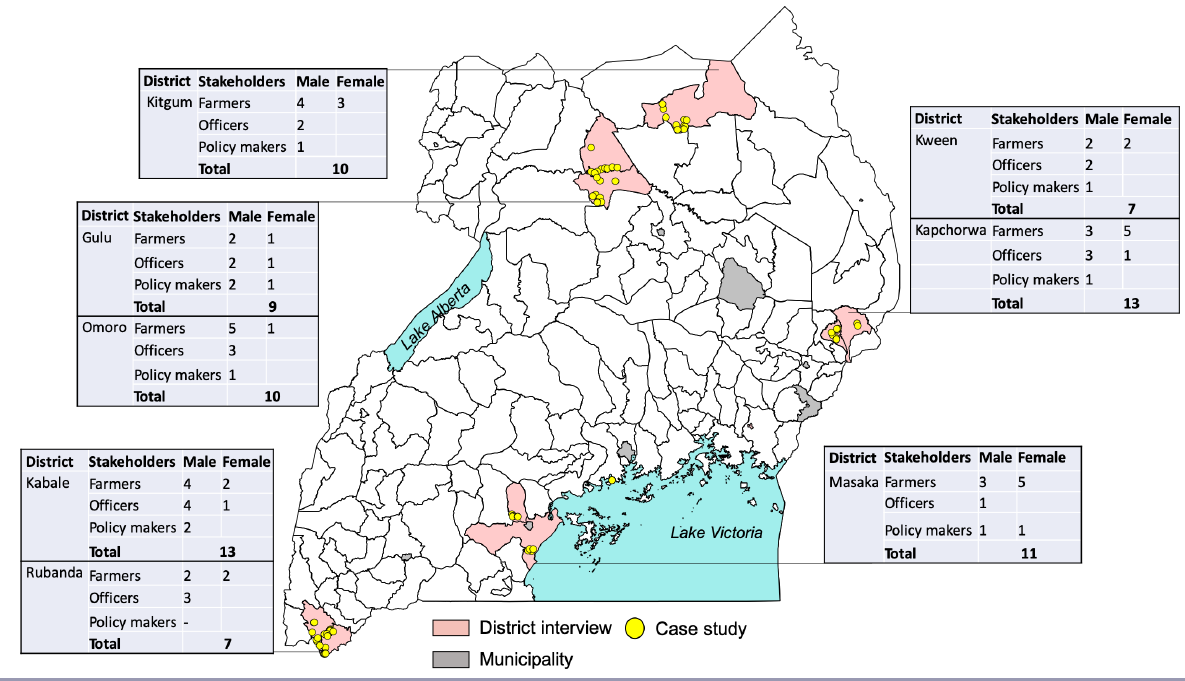
Fig. 2. Map showing the distribution of the interviews in Uganda and stakeholder characteristics for each district. Municipalities (in grey) were excluded from analysis because they represented non-rural contexts. Pink = disticts where interviews were performed.